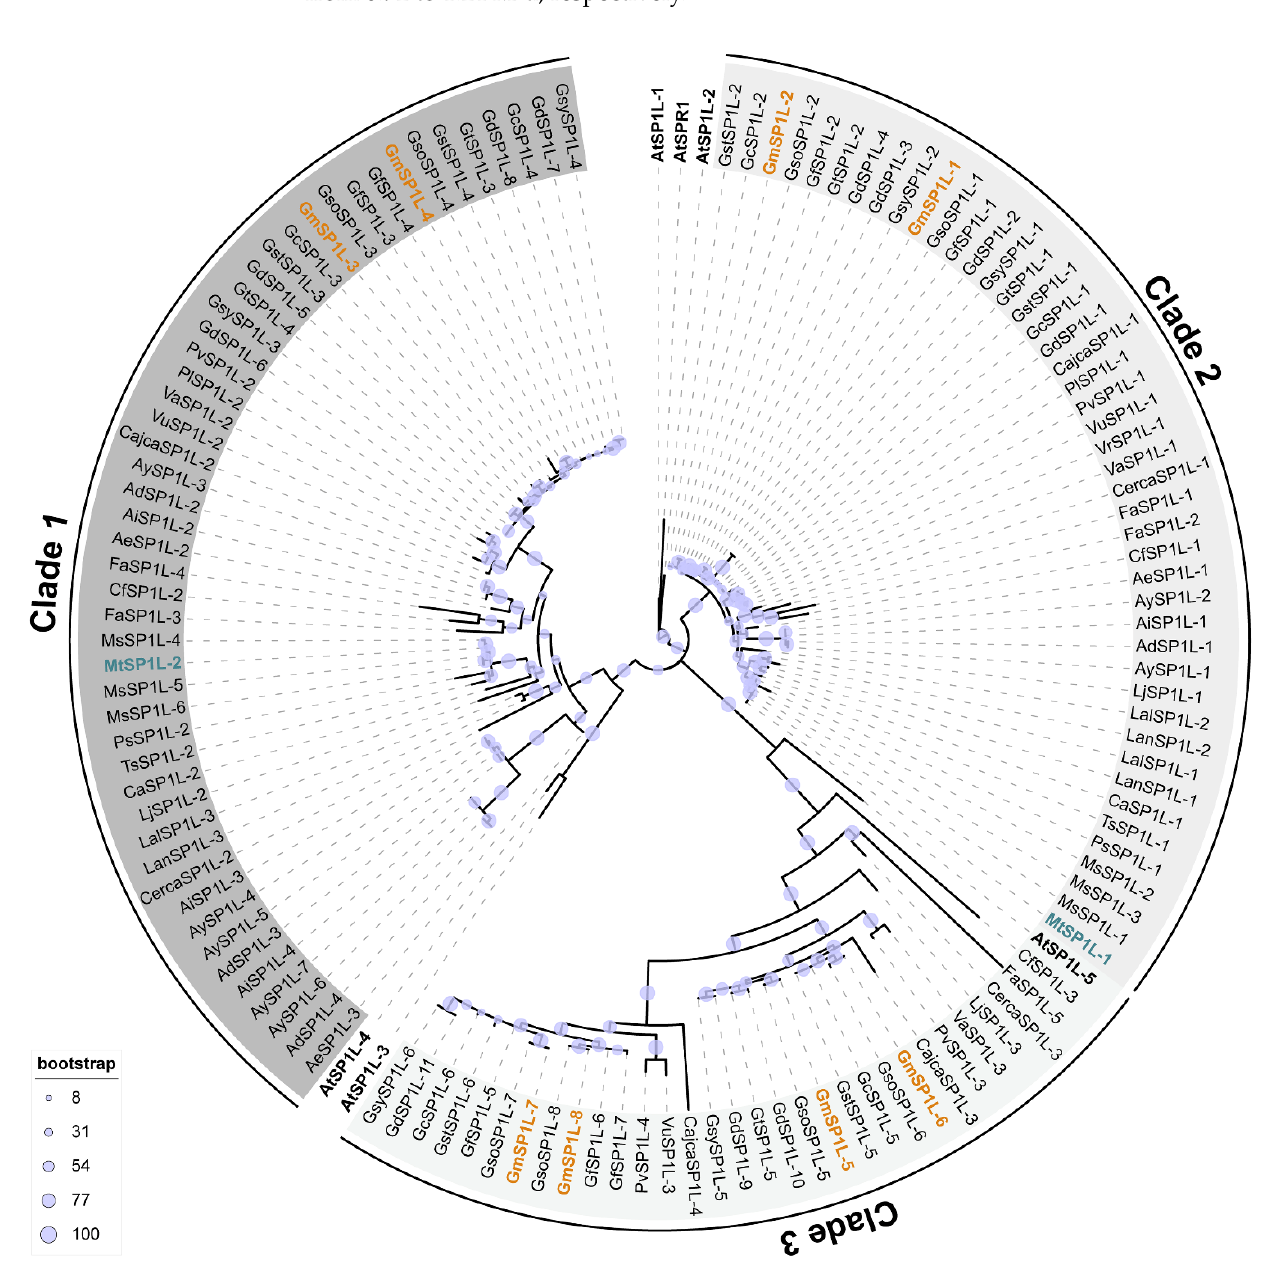
Figure 1. Phylogenetic analysis of the SPIRAL1 (SPR1) families across the Leguminosae species and Arabidopsis thaliana . Clades are shaded with different gradients of grey. The Arabidopsis ( At ) SPR1 family proteins are bold, and the SPR1-Like (SP1L) proteins from Medicago truncatula ( Mt ) and Glycine max ( Gm ) are highlighted with blue and orange, respectively.